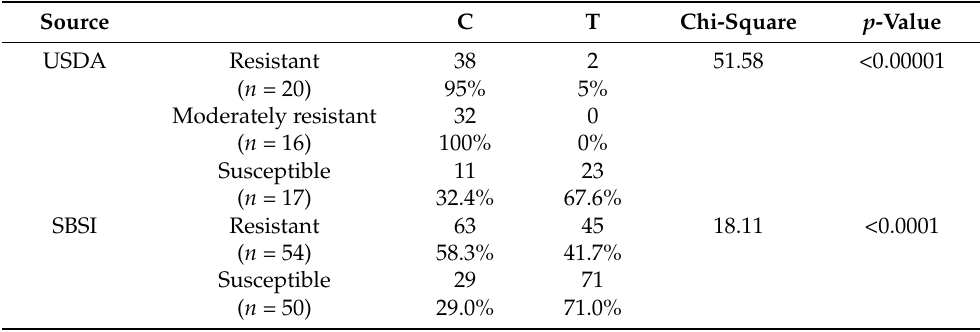
Table 2. Contingency table based on rhAmp genotyping of RsBv1 on resistant and susceptible material from USDA and SBSI. The chi-square value provides a measure of the correlation between the categorical variables (the phenotype and the allele of the SNP in each case), and the p -value of the statistical test resulted significant ( p <